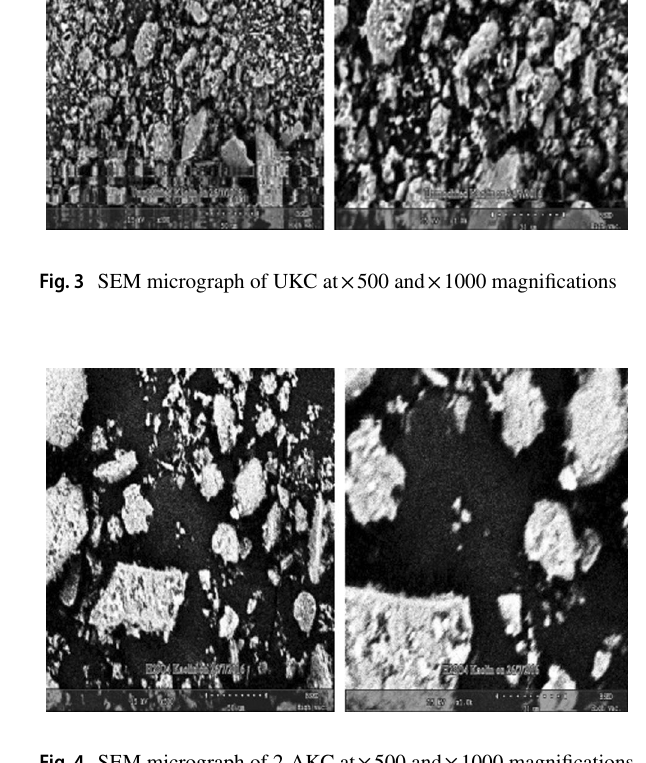
Fig. 4 SEM micrograph of 2-AKC at × 500 and × 1000 magnifications